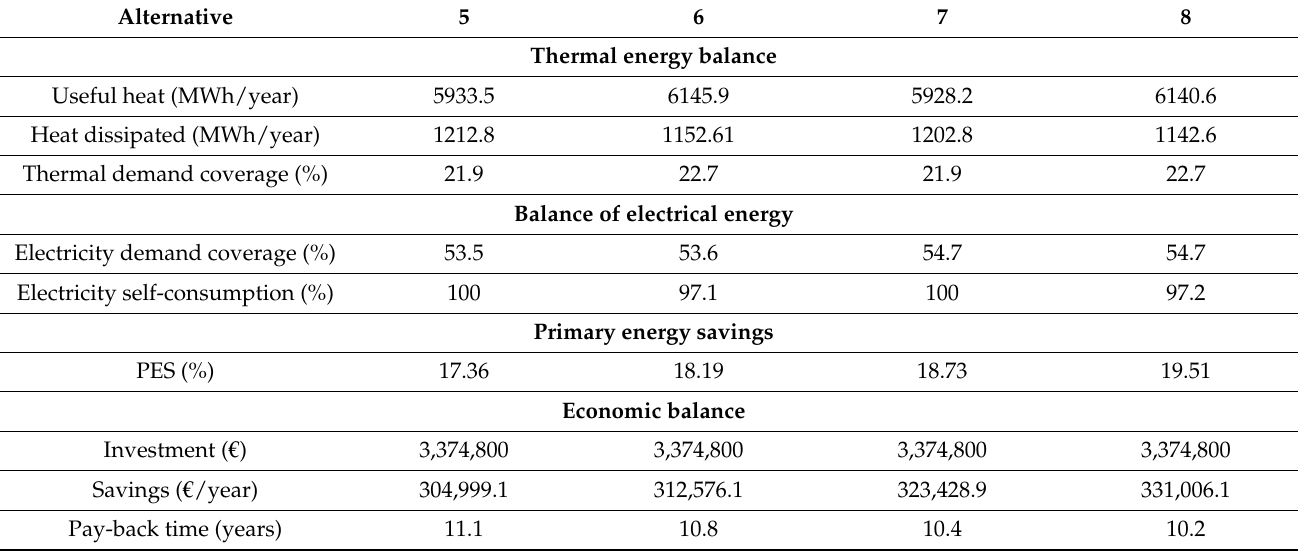
Table 10. Comparison of alternatives of the 1 MW of electrical power cogeneration